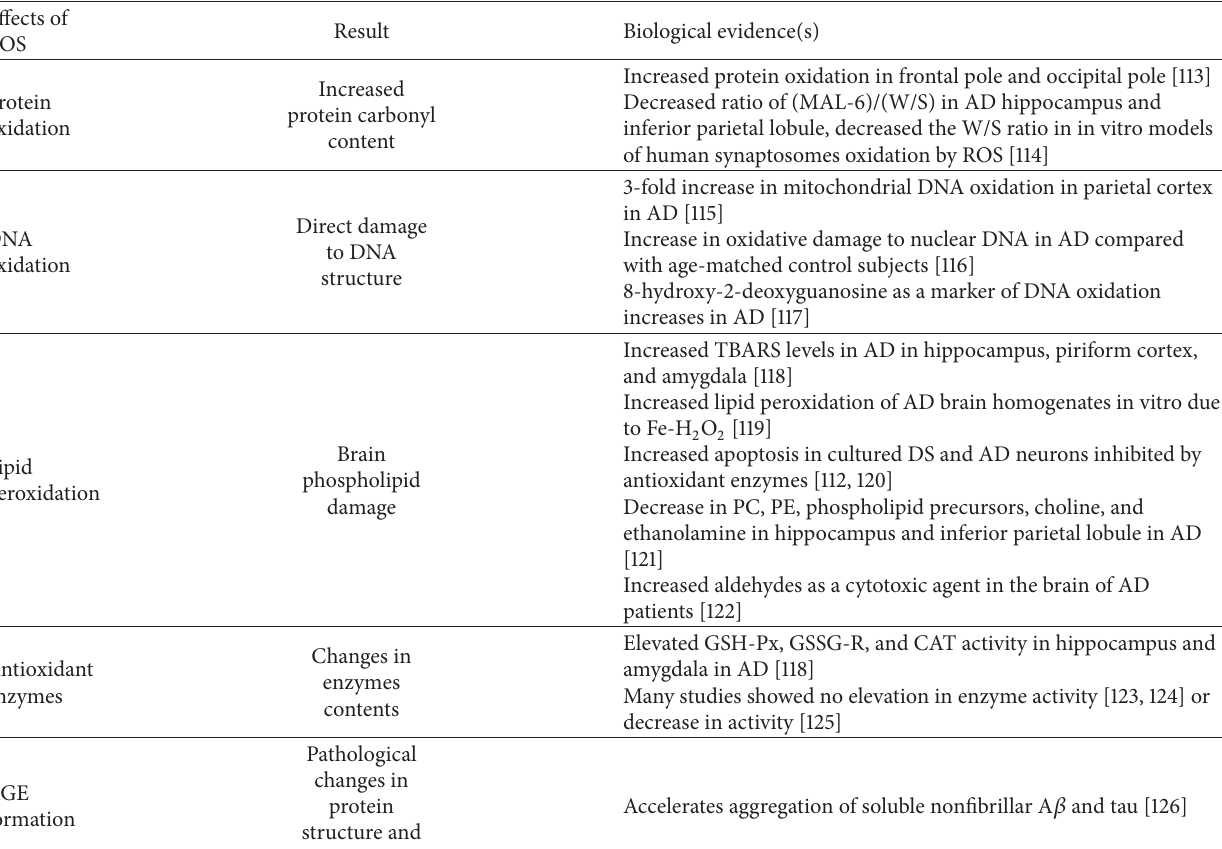
Table 2: Major effects of oxidative stress in the pathogenesis of Alzheimer’s